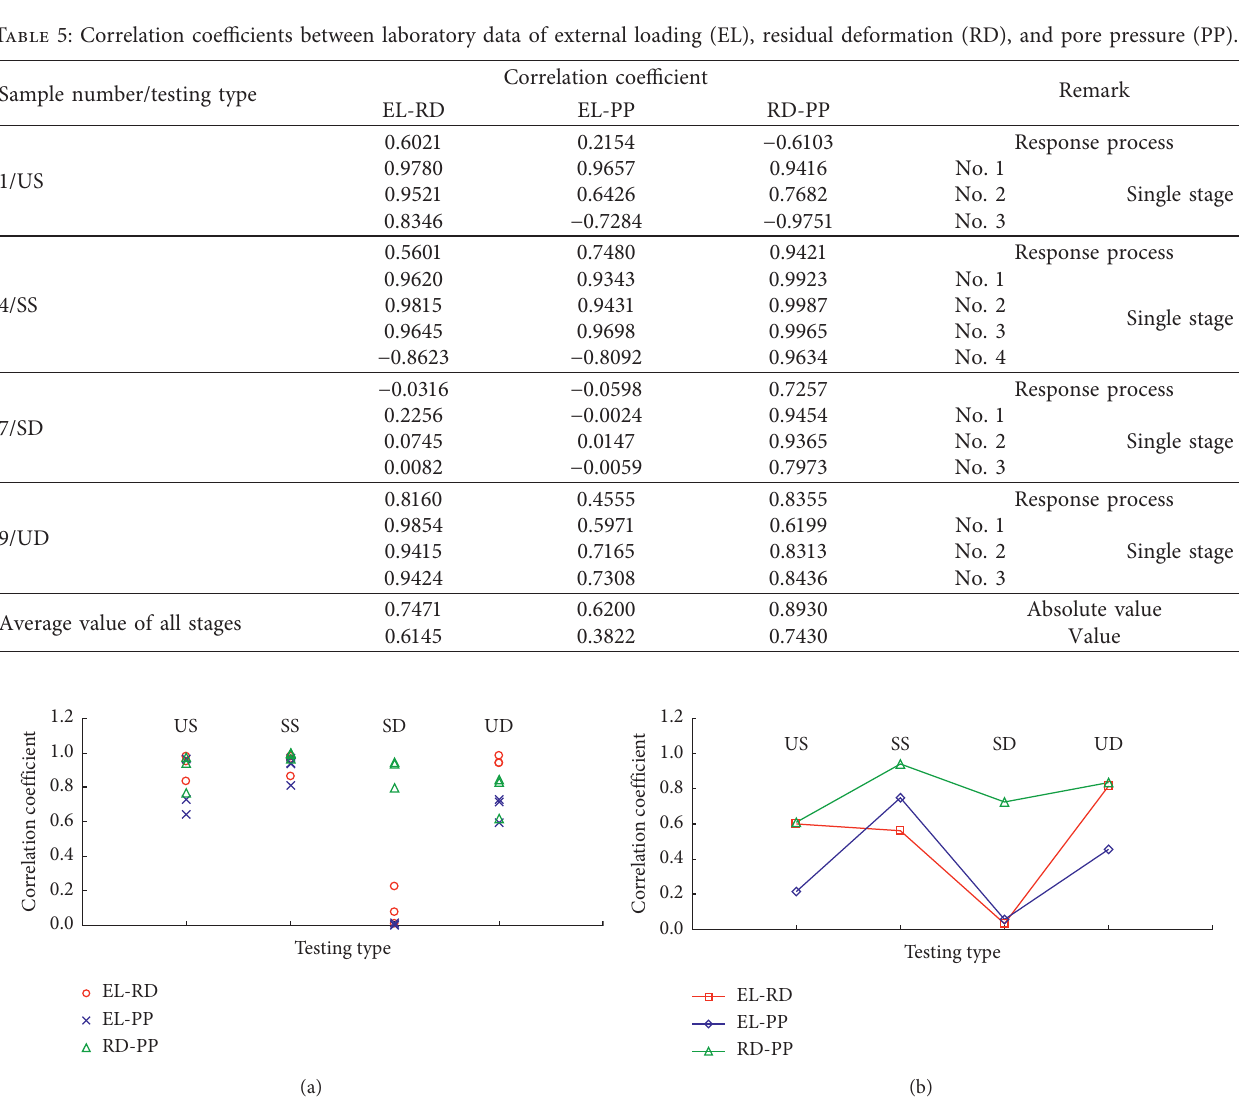
Figure 5: Correlations between external loading, residual deformation, and pore pressure (US/UD: air pressure; SS/SD: water pressure). (a) Different stages. (b) Response process.